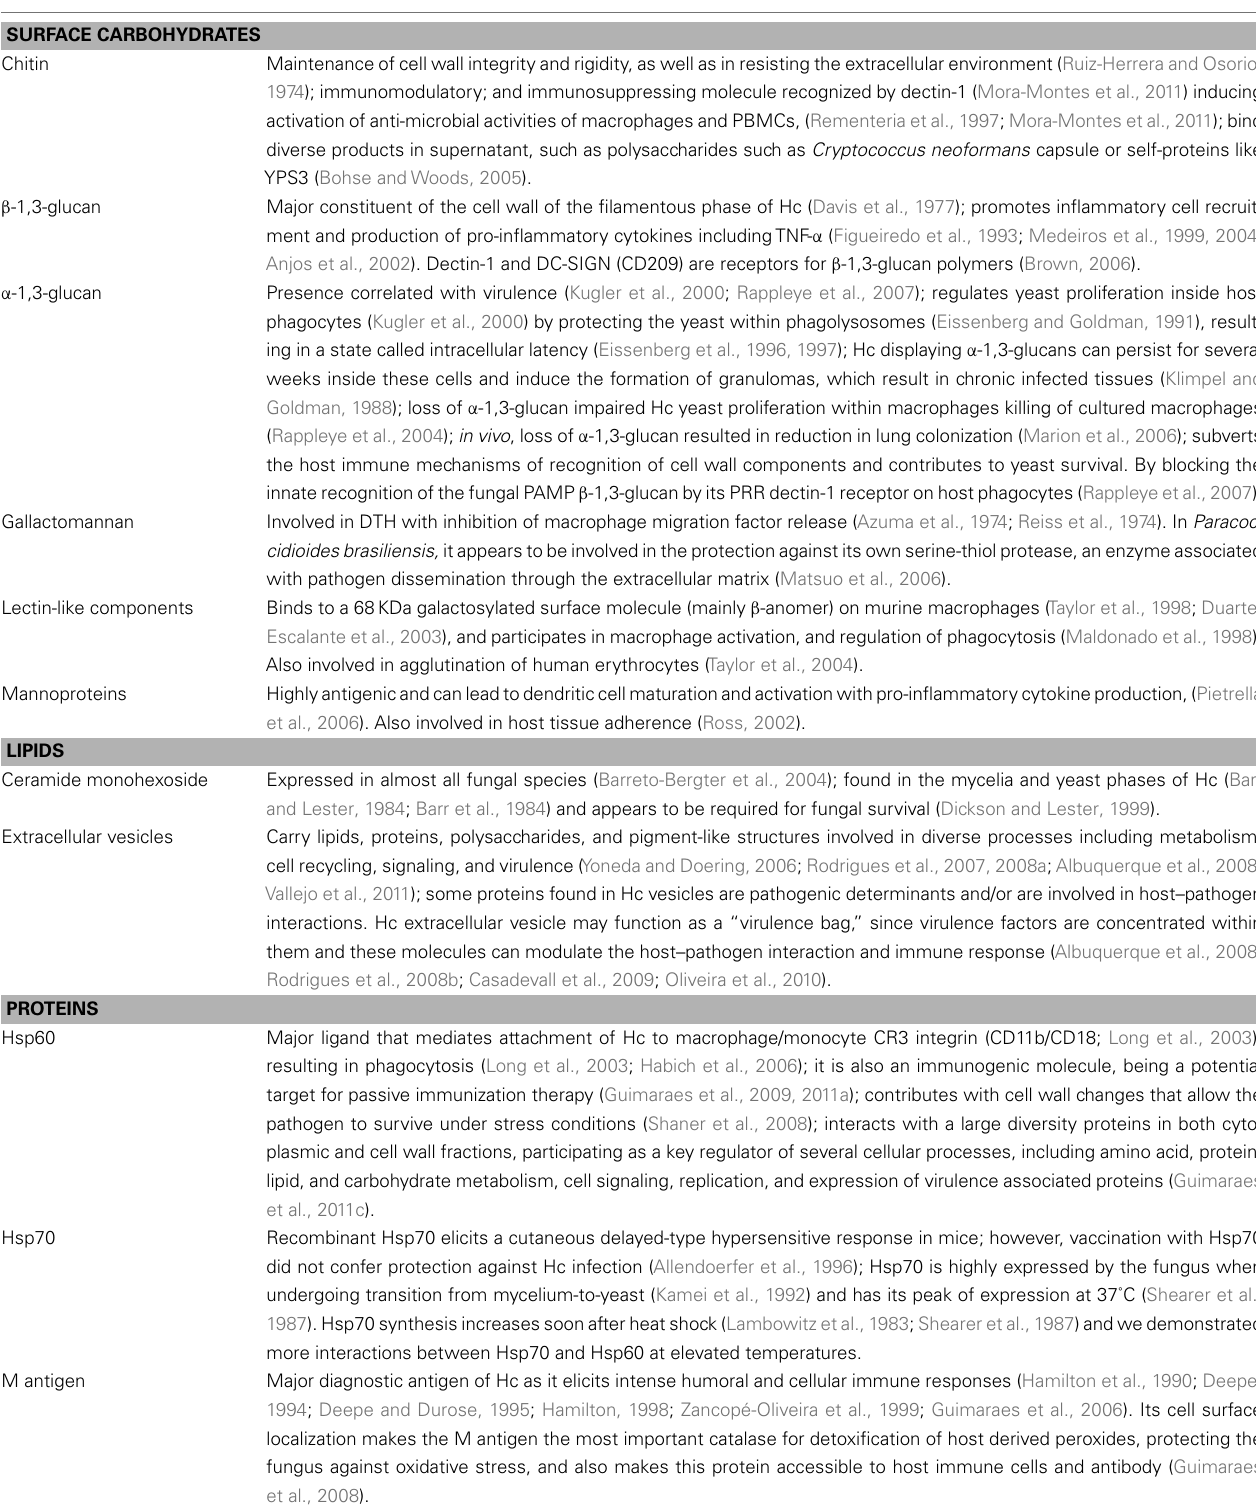
Table 1 | Components of Hc cell surface and their role in